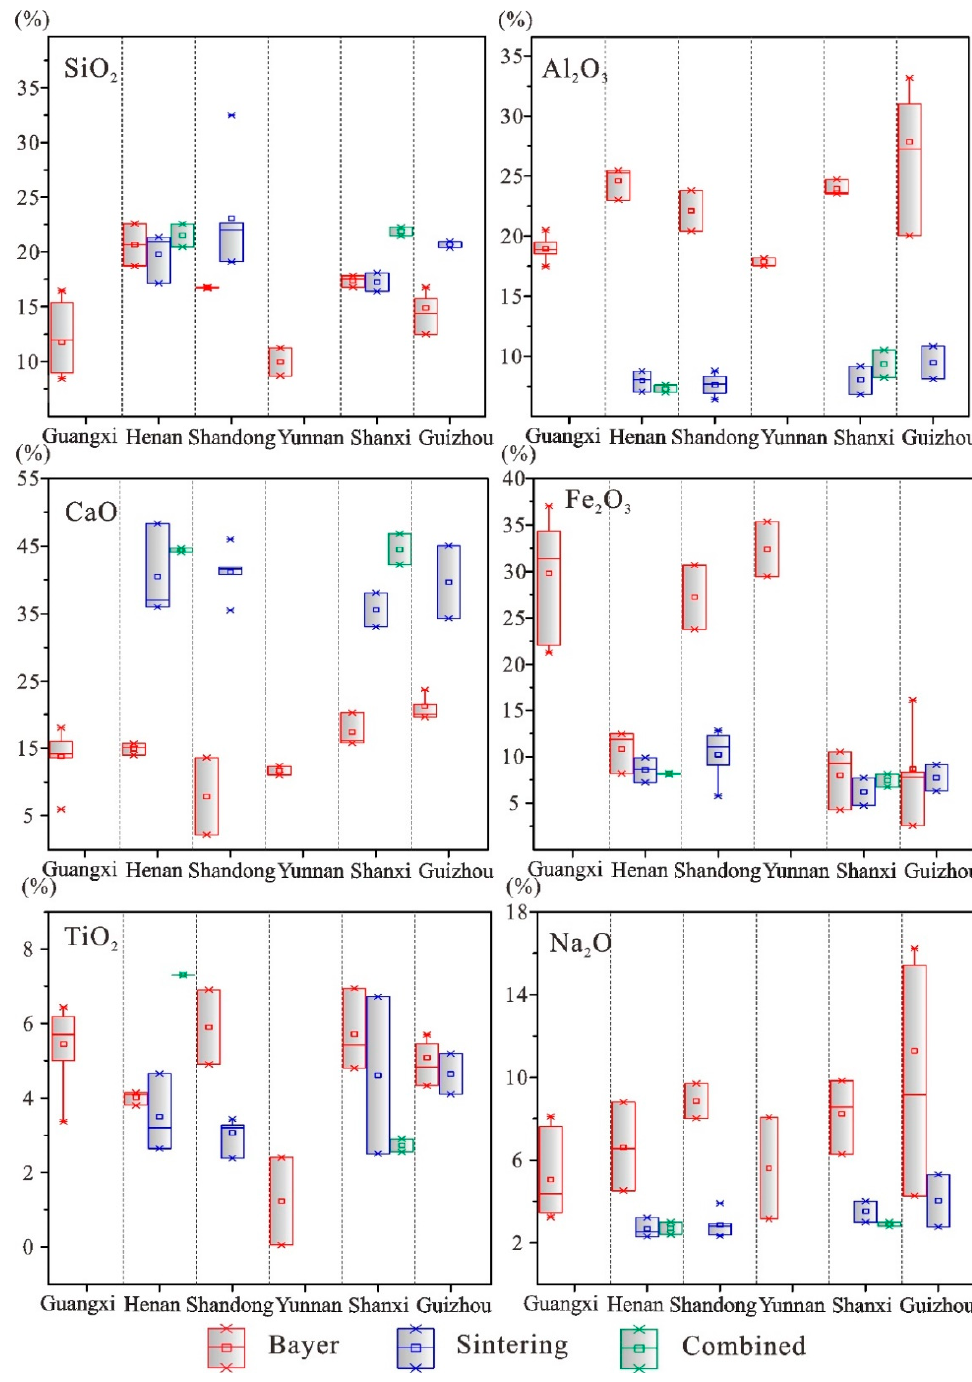
Figure 2. Box plot of chemical composition in Red Mud from the alumina manufactures in China.